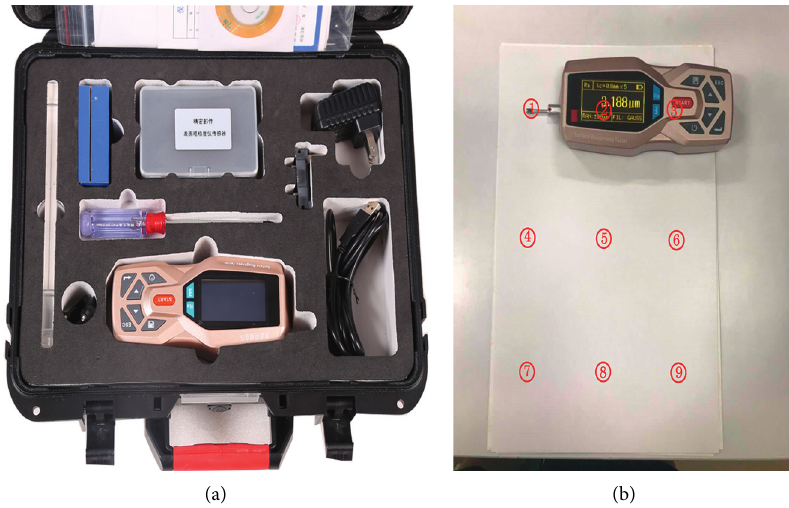
Figure 3: Surface roughness meter (a) and test number design